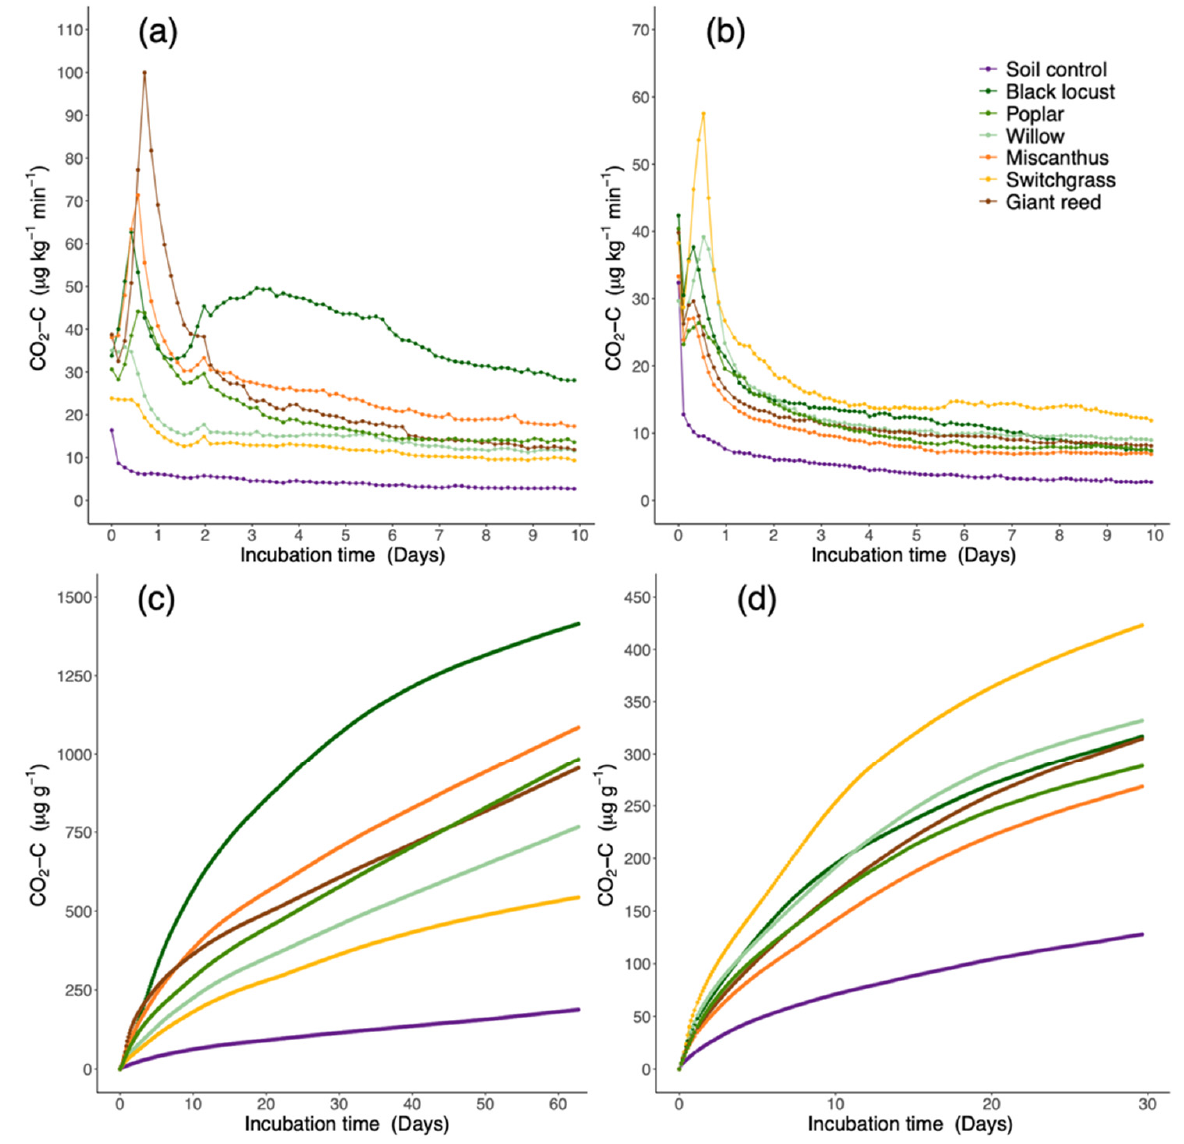
Figure 2. Rate ( a , b ) and net cumulative measured ( c , d ) CO 2 emissions from soil incubated with different components of PBCs belowground biomass as EOMs (( a – c ): stumps/rhizomes and ( b – d ) fine roots) during 30 and 60-day laboratory incubations. For the rate of respiration, only the first 10 days of the incubation are reported. Respiratory curves are presented on the y axis with a different scale for better visualization.